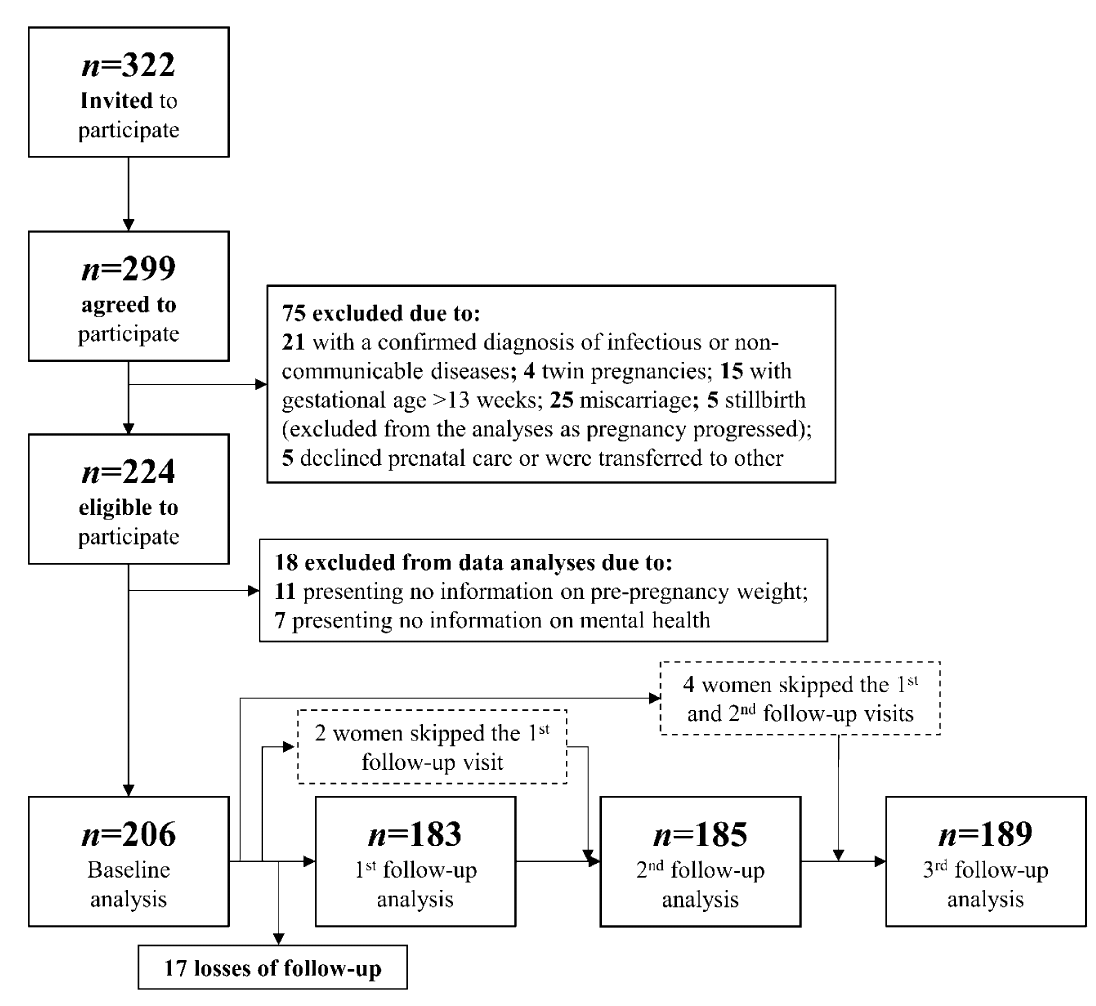
Figure 2. Flowchart to illustrate recruitment process and sample